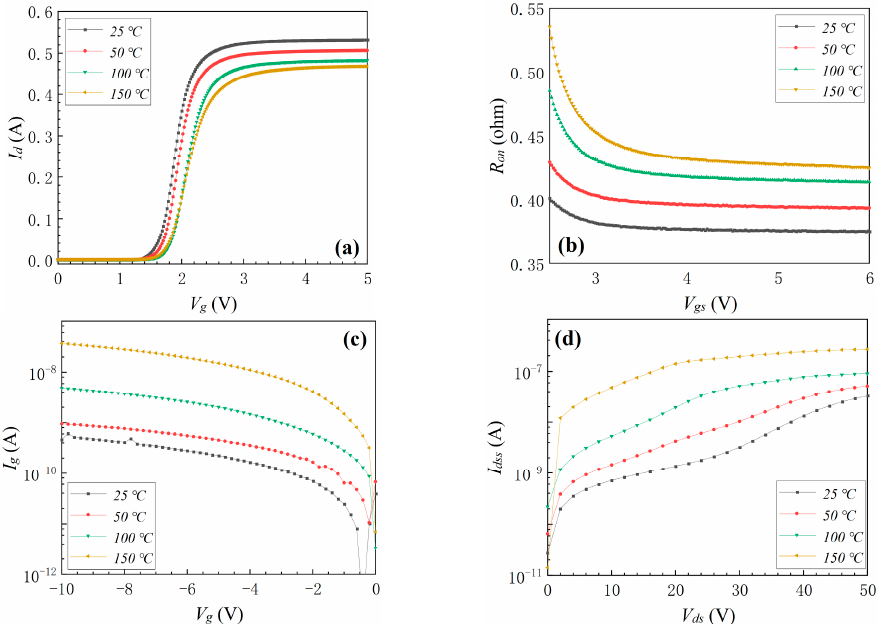
Figure 7. The device’s transfer characteristic ( a ), R on ( b ), I g ( c ), and I dss ( d ) at environmental temperatures of 25, 50, 100, and 150 °C.